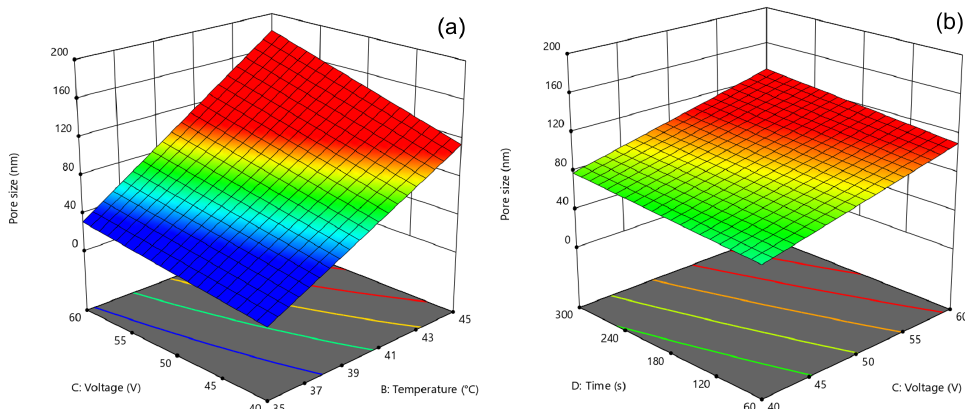
Figure 2. Three-dimensional surface plots evaluating the influence of DoE factors on the pore size. ( a ) temperature and voltage; ( b ) time and